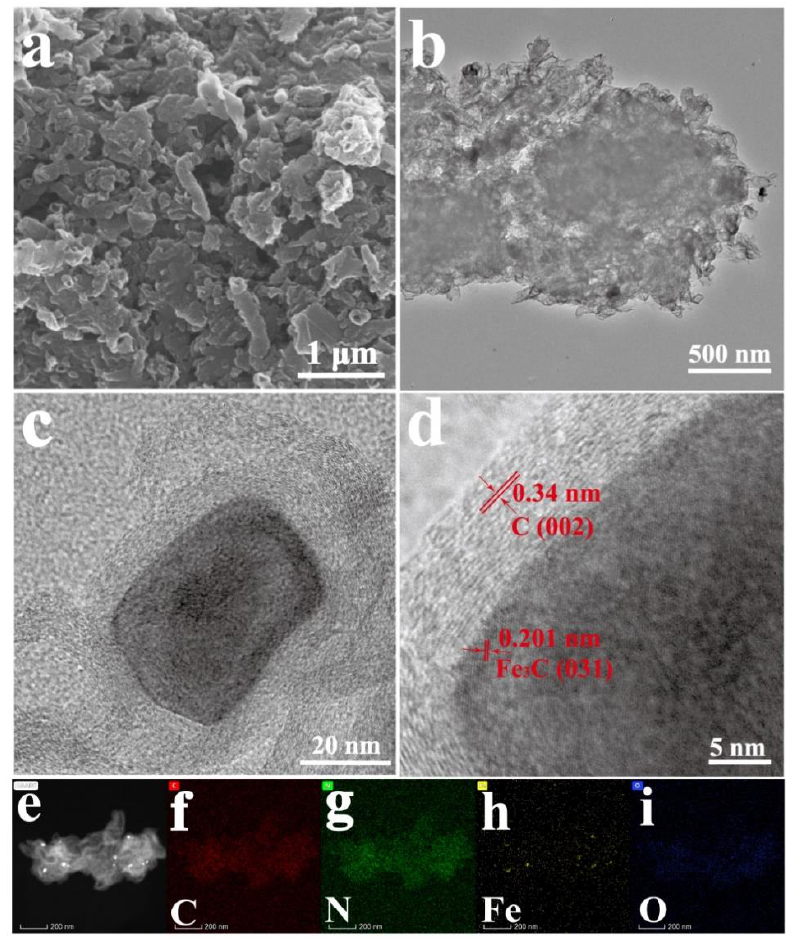
Figure 3. SEM image of CNS – 0.8Fe ( a ). TEM image of CNS – 0.8Fe ( b ). High-resolution TEM images of CNS – 0.8Fe ( c – d ). Dark-field image and EDX mappings C, N, Fe, and O elements ( e – i ) of CNS – 0.8Fe. CNS–0.8Fe ( c , d ). Dark-field image and EDX mappings C, N, Fe, and O elements ( e – i ) of